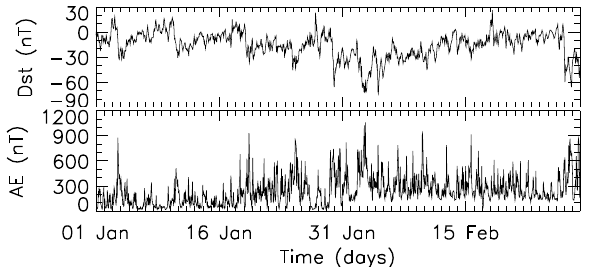
Fig. 5. D st and AE indices for January–February 2003. Fig. 6. Space-scale energy density of the D st and AE indices for January–February